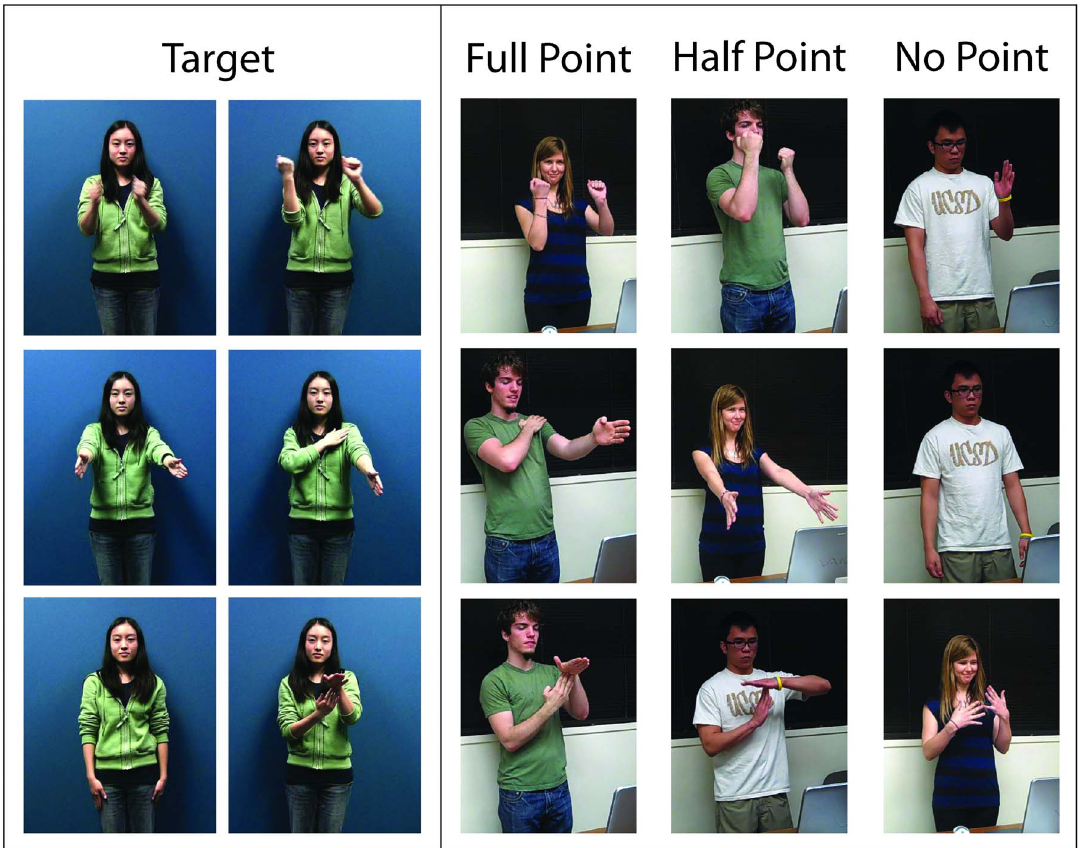
Figure 1. Recall of three target movements by three representative individuals. Participants were instructed to mirror the actress’s movements; however, for clarity, her postures have been reversed in the freeze frames, enabling direct comparison between target and recall. All individuals have given written informed consent to publication of their image.